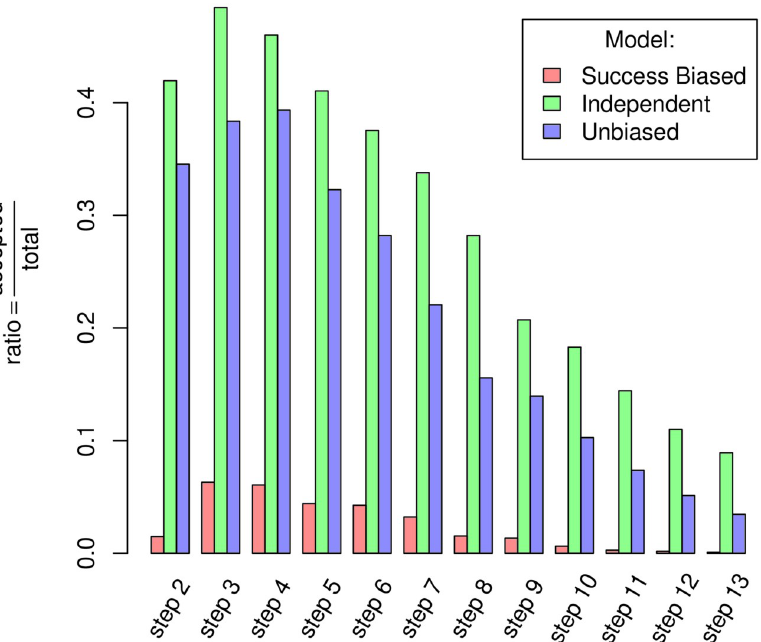
Fig 4. ABC accepted simulation ratio. Evolution of the ratio between the number of accepted simulation runs (ie simulations generating output s where δ ( s , d ) < � step ) and the total number of simulations needed to accept 500 simulations at each step of the ABC algorithm and for the three models. The first step has been removed as it represents an � big enough to accept any simulation run, which leads to a ratio of 1 for all models.